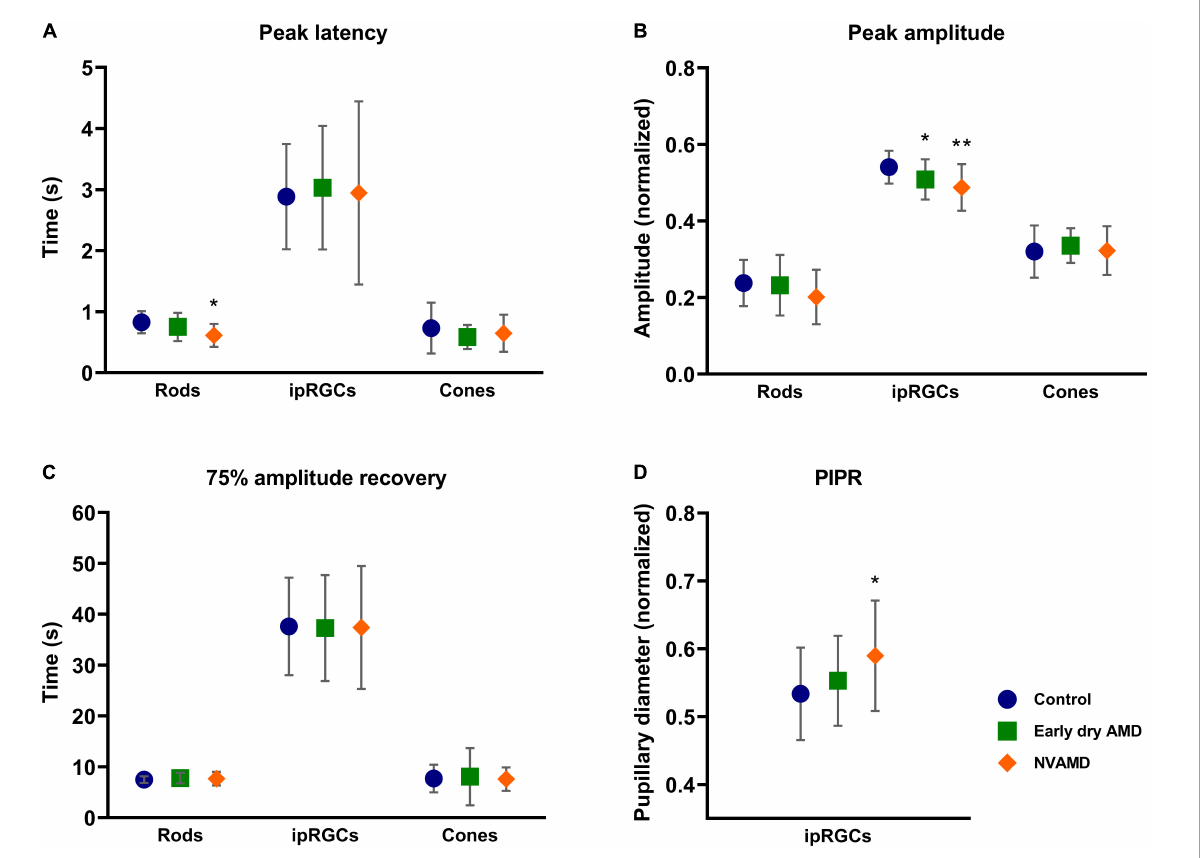
FIGURE4 Average and standard deviation of peak latency (A) , amplitude (B) , 75% amplitude recovery time (C) , and post-illumination pupil response (PIPR) (D) for early dry age-related macular degeneration (AMD) (green square), NVAMD (orange diamond), and the control groups (blue circle) for rod-, melanopsin-, and cone-driven stimuli. NVAMD, neovascular age-related macular degeneration. * p < 0.05, ** p < 0.01.